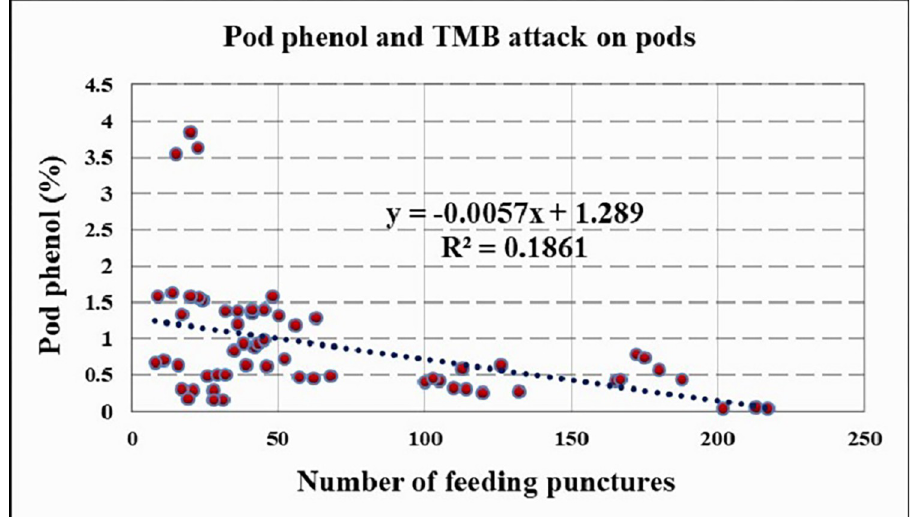
Fig 3. Correlation between pod phenol (%) and number of feeding lesion on pod.